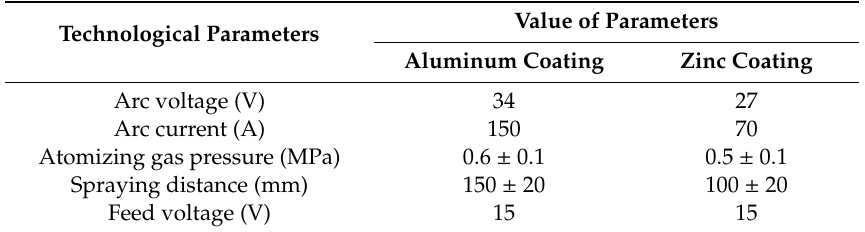
Table 2. Technological parameters of arc-spraying.